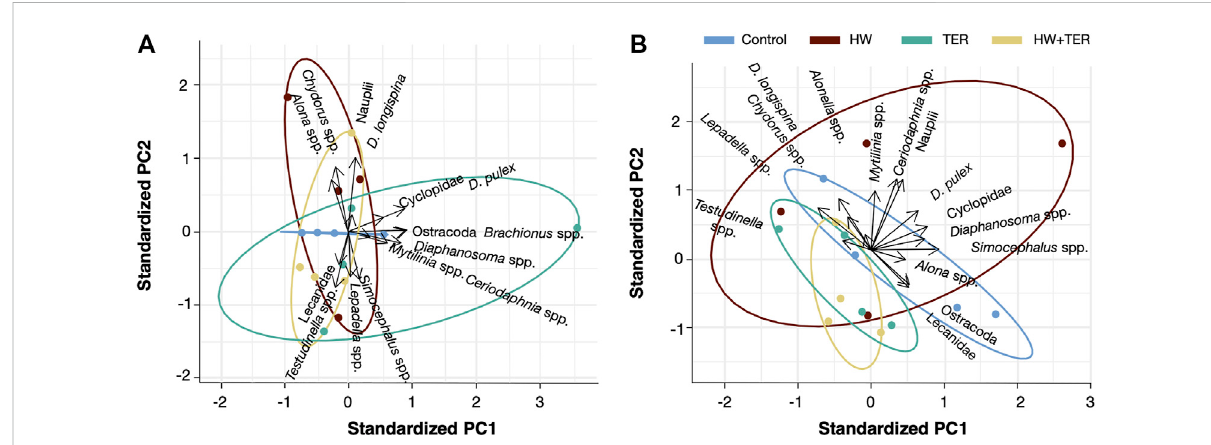
FIGURE 4 Principal Component Analysis (PCA) indicating the relationship between the treatments (control, heatwave (HW), terbuthylazine (TER), and the combination (HW + TER)) and the individual taxa. The length and direction of the arrows indicate the af fi nity of each stressor for each taxon, respectively. (A) PCA of day 7 (B) PCA of day